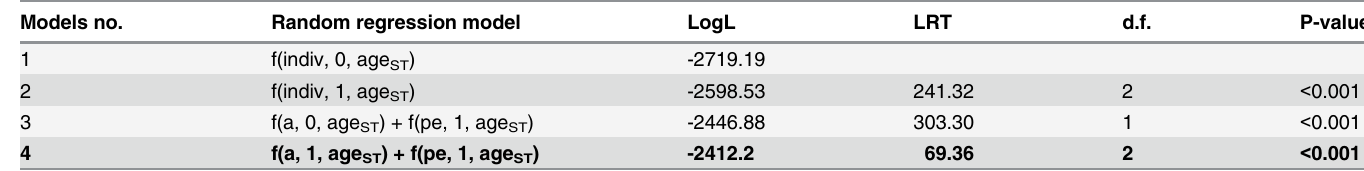
Table 5. Results of the selection strategy of the best random regression animal model for egg production. LogL, the Log Likelihood of the model, LRT the likelihood ratio test, d.f., the degree of freedom defined as the number of random term(s) (variance(s) and covariance(s)) added for fitting each model in comparison of previous model. Note that f(indiv, 2, age ST ) did not converge. A plot of the best model can be found in Fig 2 (using MCMCglmm estimates) and in S3 Text (using ASReml estimates). Models no.